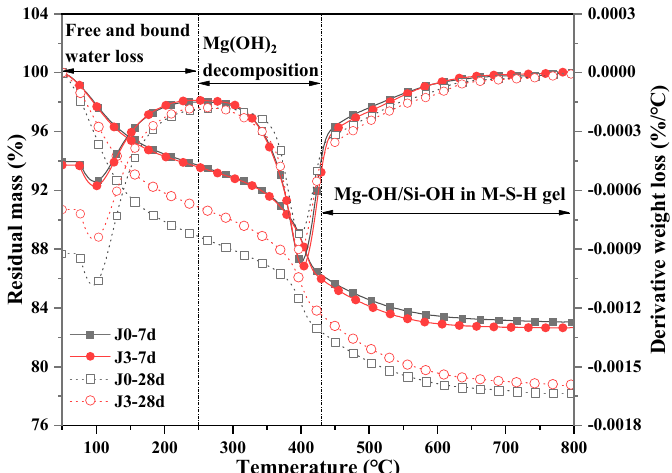
Figure 12. TG and DTG curves of M-S-H cement with SRA under sealed conditions.